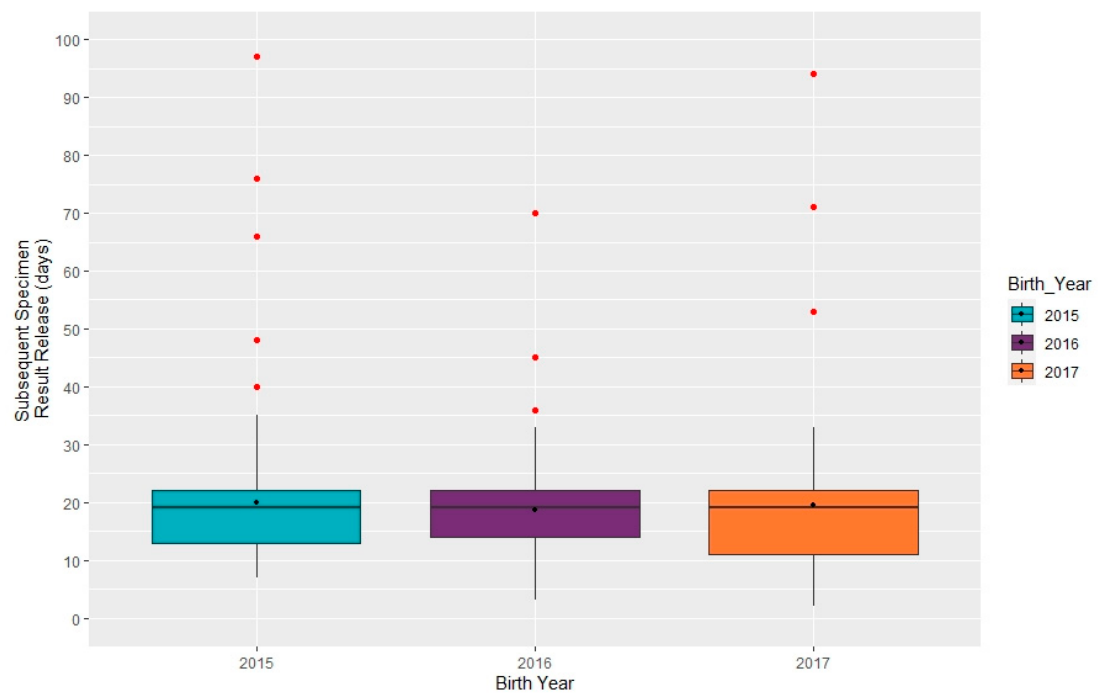
Figure 10. Congenital adrenal hyperplasia cases: subsequent specimen result release of out-of-range results, by year ( N =